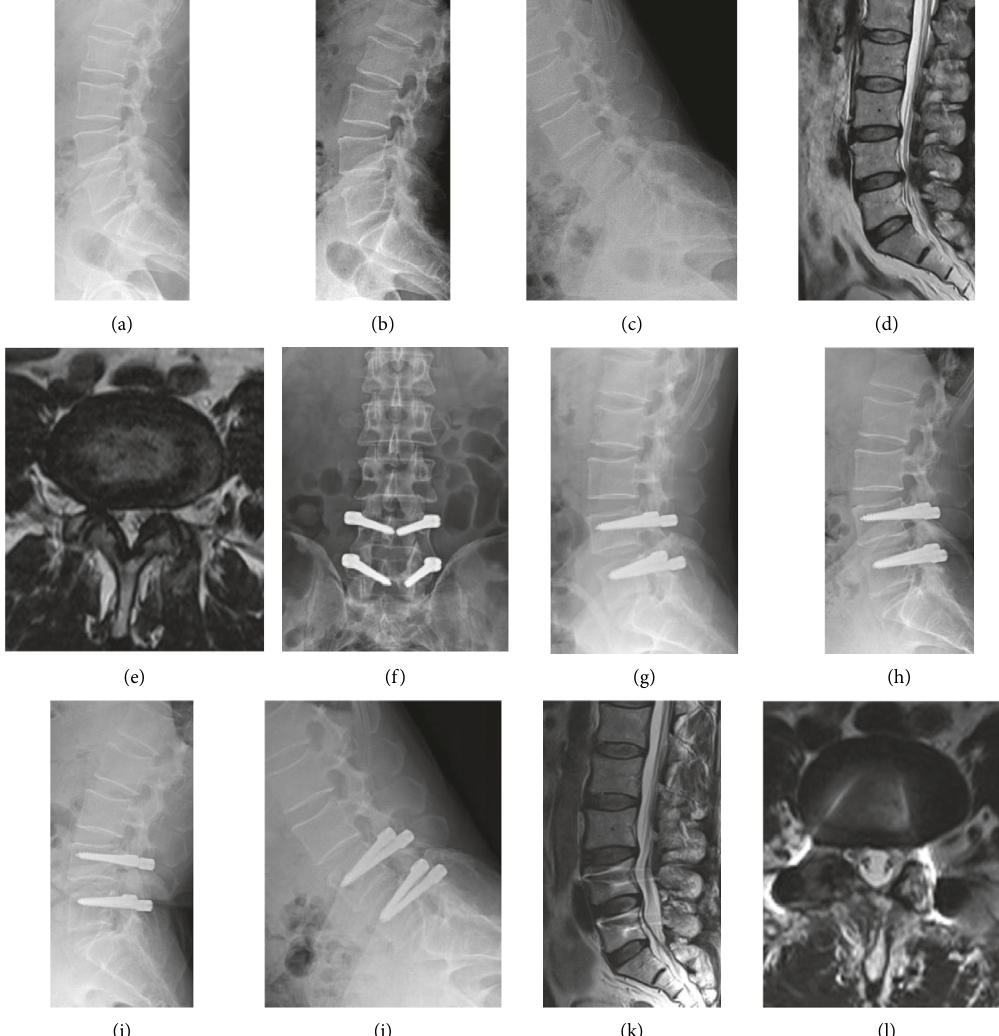
Figure 1: The typical cases in group A. A 57-year-old male patient developed L4/5 spinal stenosis who was assigned group A. A–E show the preoperative X-ray and MRI scans. The intervertebral height and ROM of surgical were 11.35mm and 5.5 ° , respectively. MRI scans showed the spinal stenosis was severe on the right side. The Pfirrmann grading was grade 3. The patient underwent spinal decompression without discectomy and Dynesys dynamic fixation. F and G show the 1-week postoperative X-rays. H–L show the 2-year postoperative X-ray and MRI scans. At the 2-year follow-up, the intervertebral height and ROM of surgical were 10.5mm and 4.4 ° , and the retained percentages were 92.5% and 80.0%, respectively. MRI scans showed there was no stenosis in the spinal canal and disc herniation improved. The Pfirrmann grading was grade